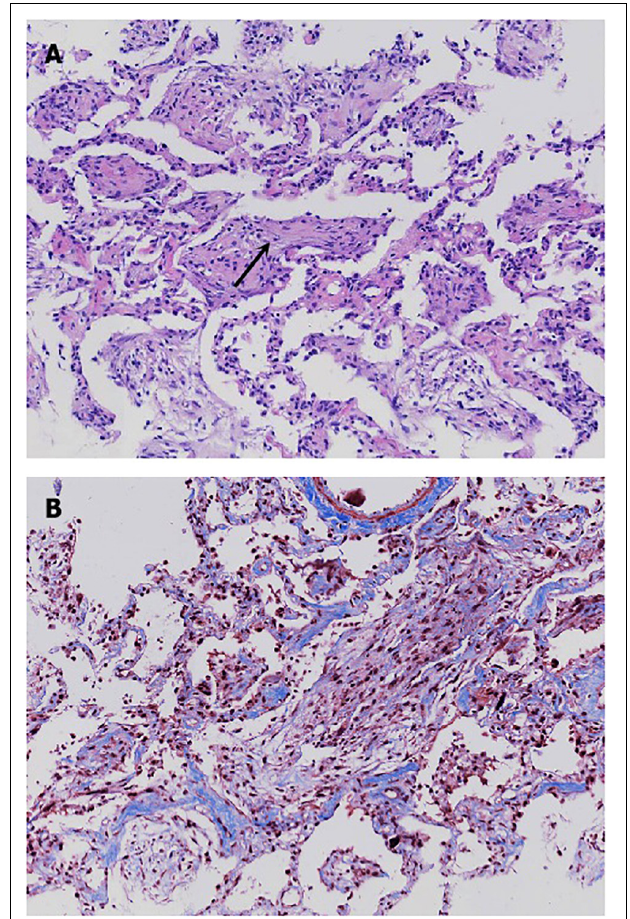
FIGURE 3 | Histological patterns of the patient’s lung tissue. (A) Hematoxylin-eosin stain revealed the presence of fibroblasts intermixed with loose connective tissue and collagen in the alveoli and the distal bronchioles. (B) Masson stain showed a mass of blue collagen fibers stained with aniline